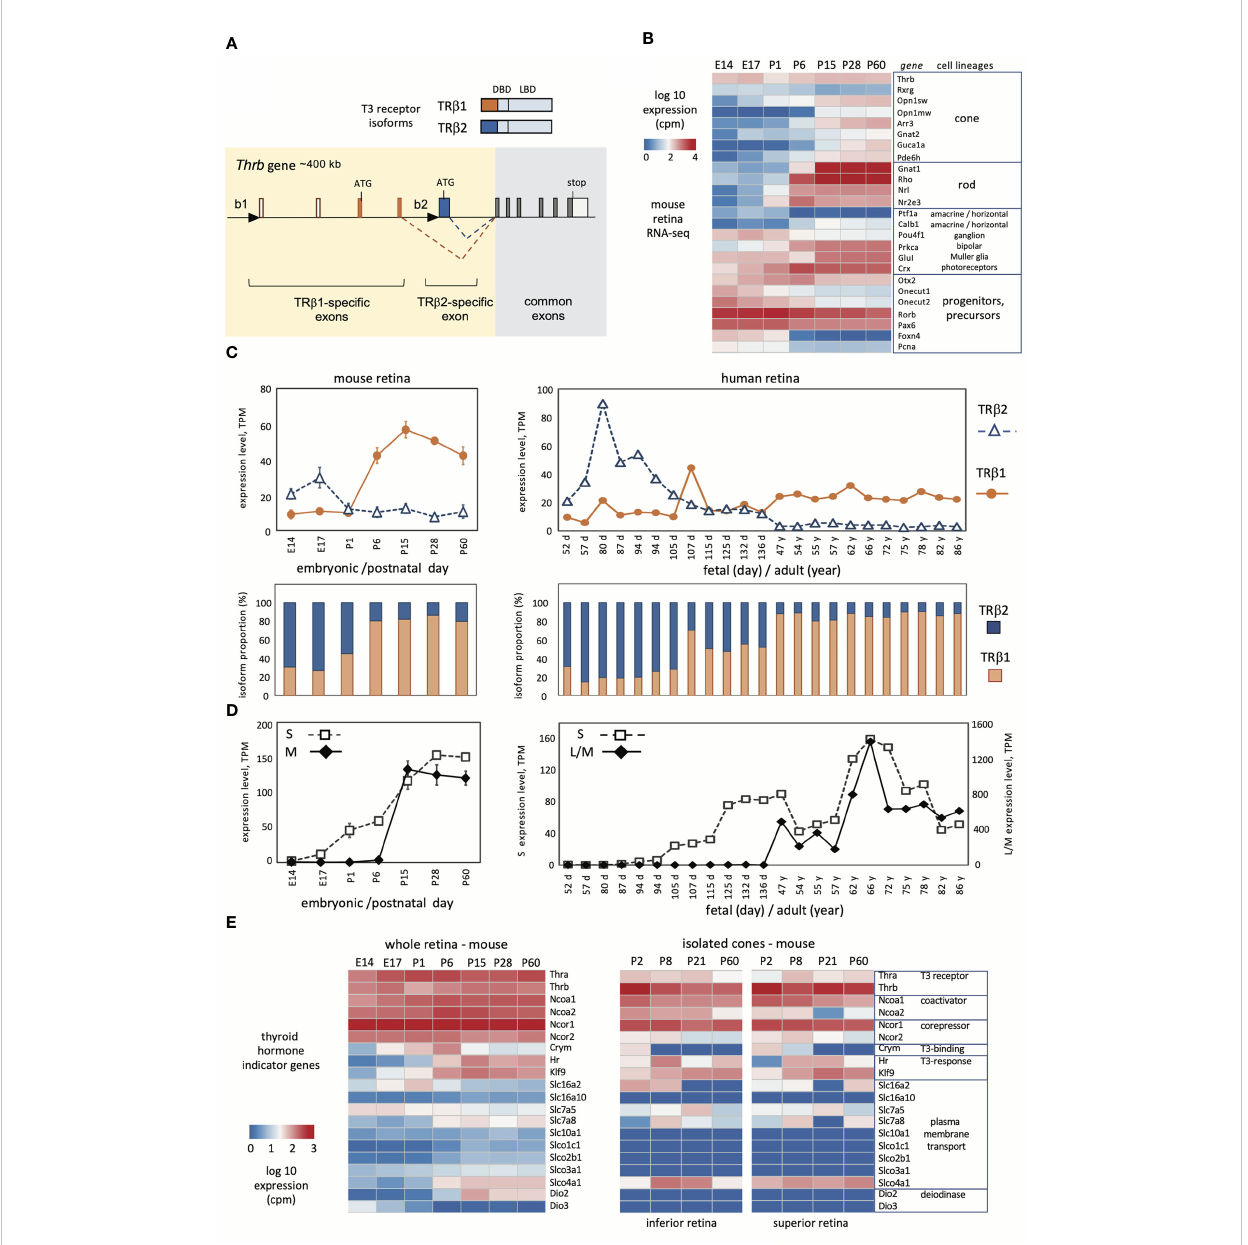
FIGURE 1 Developmental pro fi les of TR b 1 and TR b 2 in mouse and human retina. (A) , Mouse Thrb gene showing TR b 1- and TR b 2-speci fi c 5 ’ -exons and promoters (black triangles) and receptor products above. DBD, DNA binding domain, LBD, ligand binding domain. (B) , Overview of retinal lineage markers in RNA-seq datasets in mice. Groups, n = 3 to 6; mean ± S.D., cutoff average = 10 cpm. (C) , Developmental pro fi les of TR b 1 and TR b 2 in mouse ( left ) and human retina ( right ). Mouse RNA-seq datapoints represent groups, mean ± S.D.; human datapoints, individual samples. (D) , Cone opsin expression in the same RNA-seq datasets; S opsin and M opsin (mouse) or L/M opsins (human). The human L/M opsin curve represents reads from both genes in the OPN1LW-OPN1MW gene cluster. (E) , Representative indicator genes for thyroid hormone signaling in mouse whole retina ( left ) or isolated cones ( right ; cones from superior or inferior